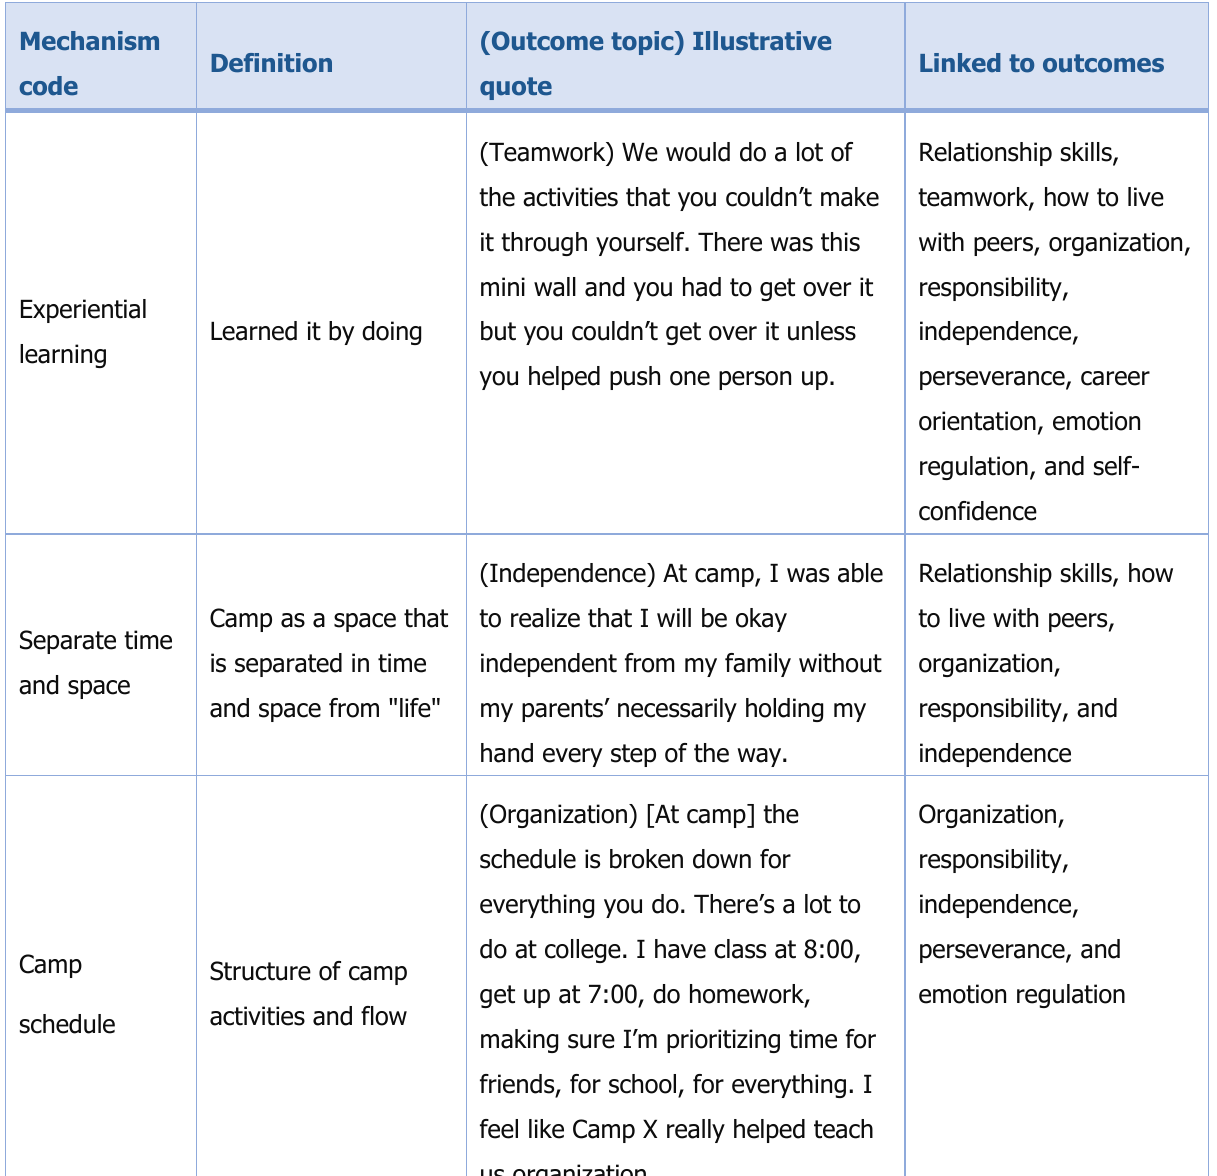
Table 4. Key Mechanisms Linked to Academic and Workplace Readiness Outcomes